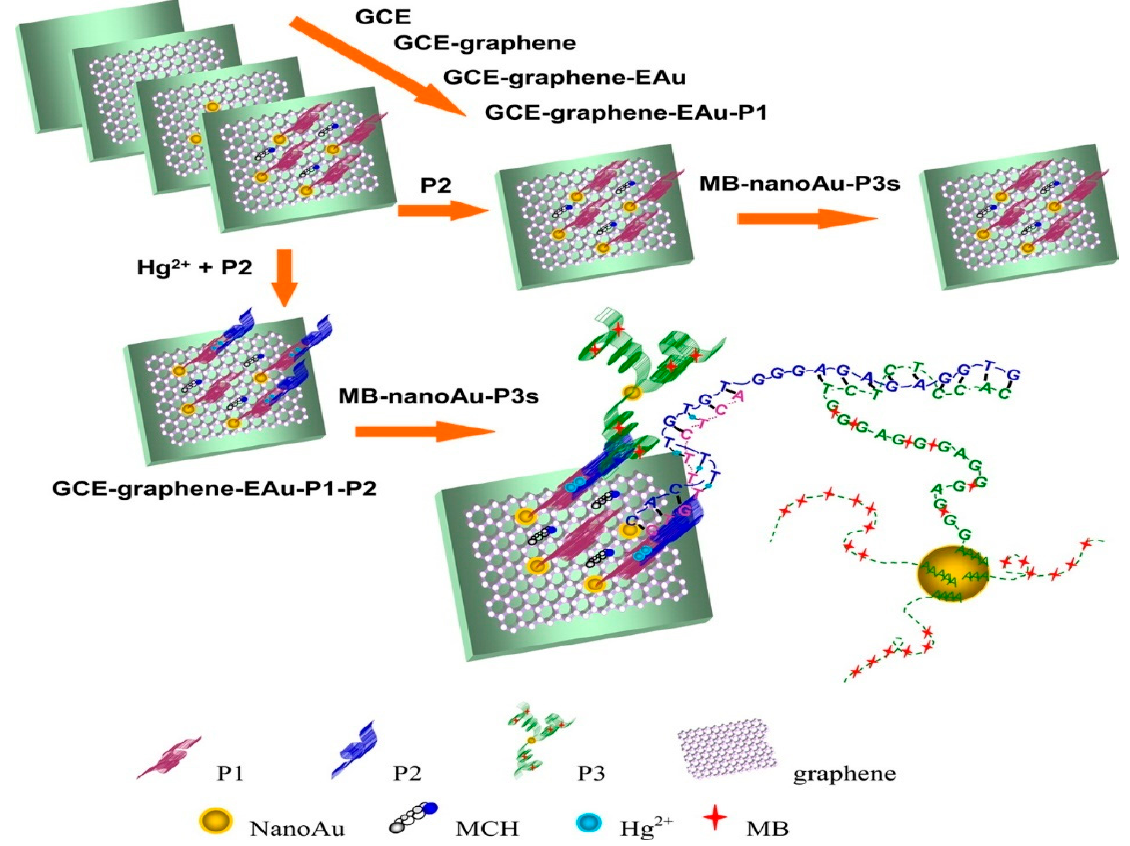
Figure 7. The outline diagram of preparation procedures of the MPH/SP@AuNPs/MWCNTs/GCE toxicant sensor for the detection of mercury. Reprinted with permission from [184]. Copyright © 2021, American Chemical Society.